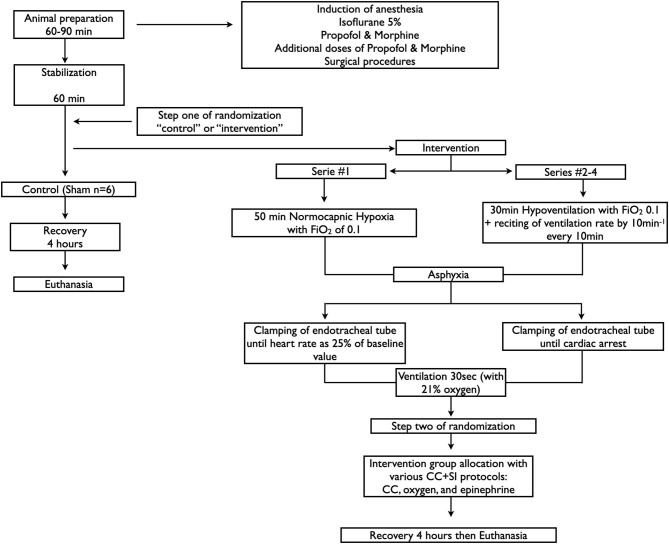
Study flow diagram.